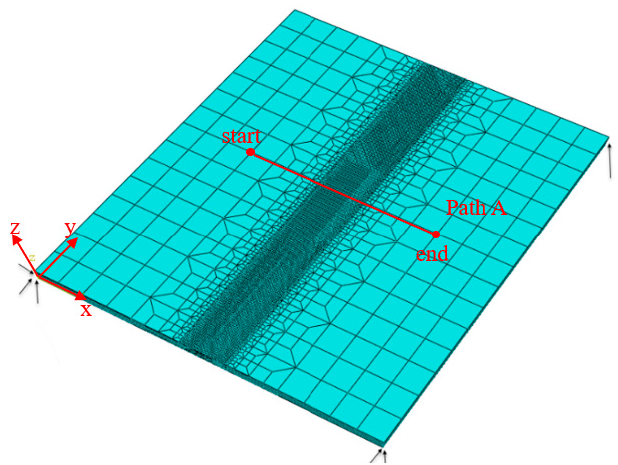
Figure 10. Three-dimensional model.